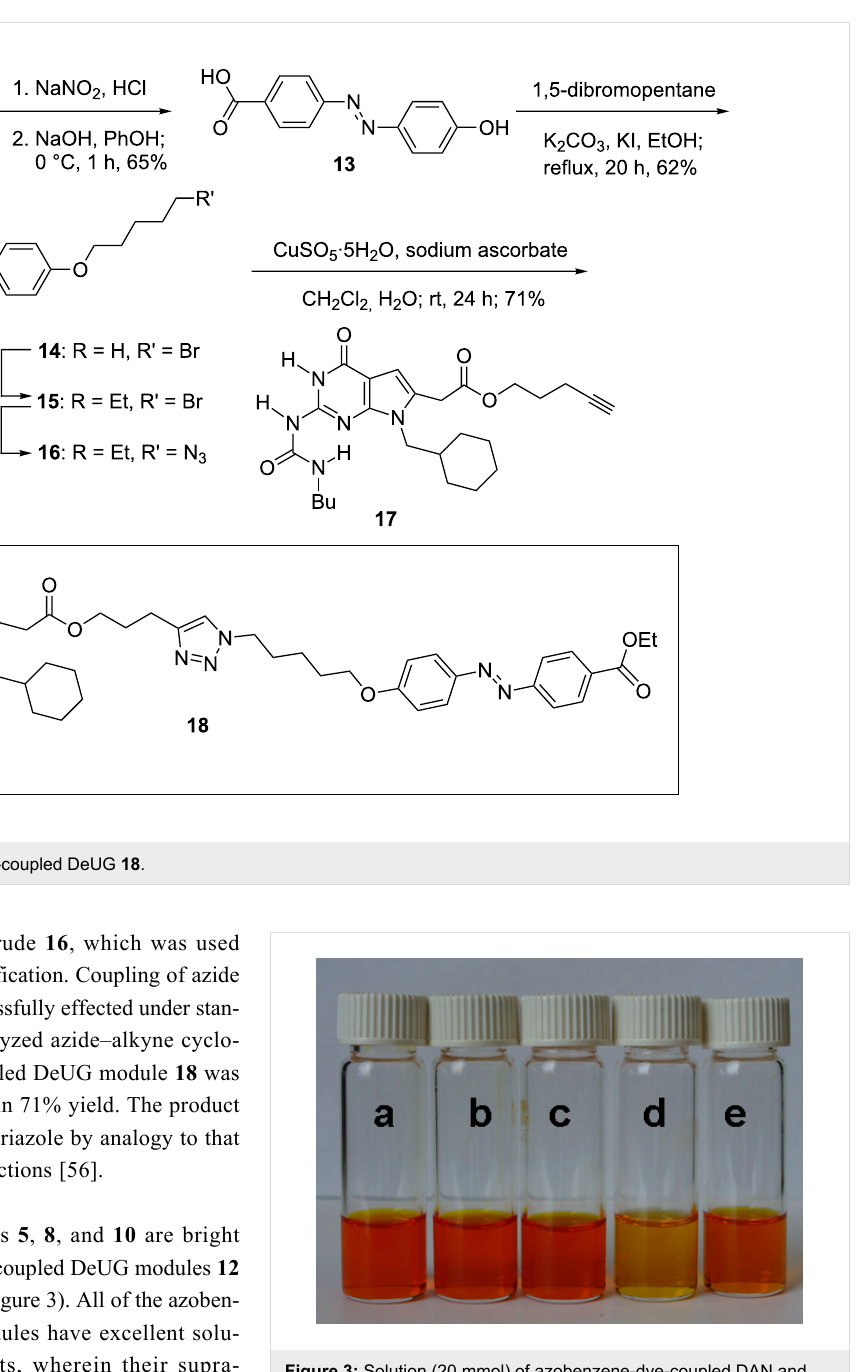
Figure 3: Solution (20 mmol) of azobenzene-dye-coupled DAN and DeUG in CH 2 Cl 2 ; a = compound 5 , b = compound 8 , c = compound 10 , d = compound 12 , e = compound 18